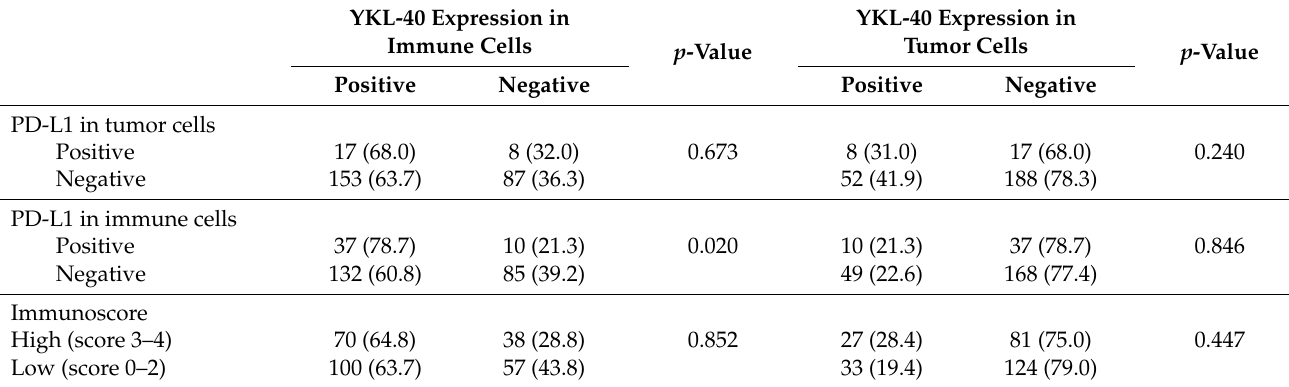
Table 2. Correlation between YKL-40 expression and various parameters in colorectal